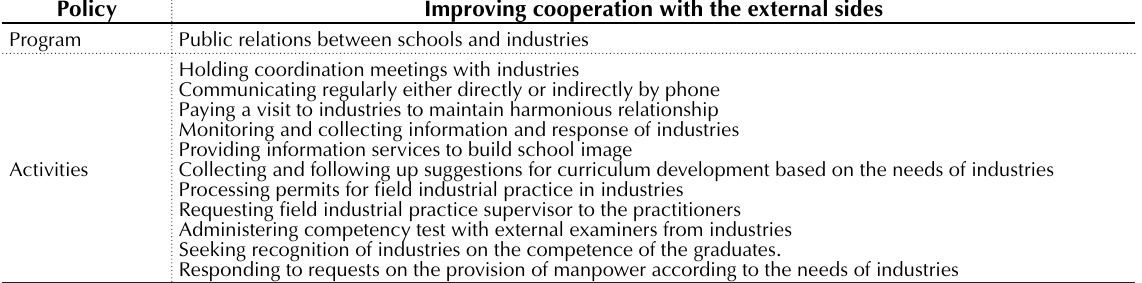
Table 2. Policy, program, and activities Policy Improving cooperation with the external sides